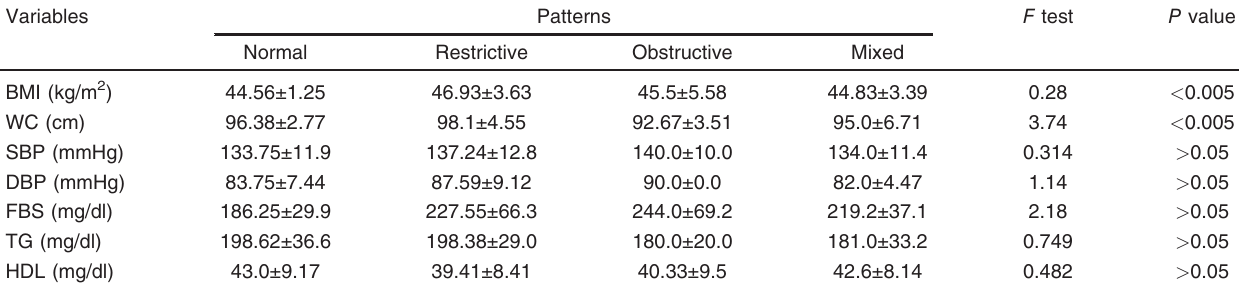
Table 5 Comparison of the components of metabolic syndrome among ventilatory pattern subgroups Variables Patterns